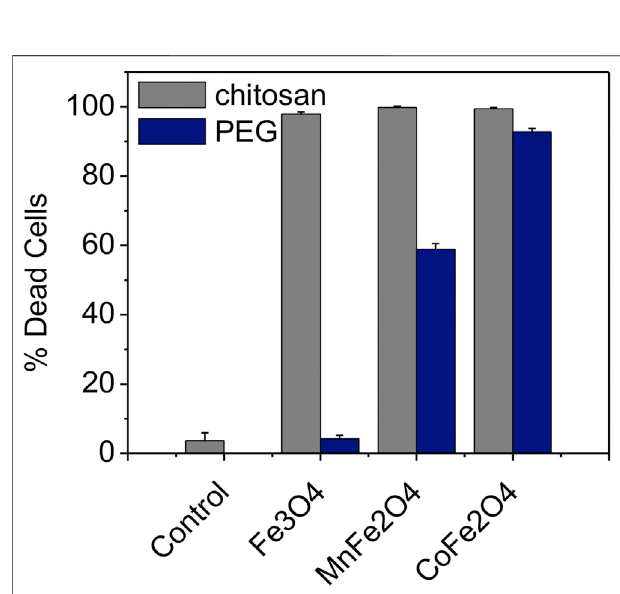
FIGURE 10 | Necrosis of 9 L tumor cells induced by 30 min of rf induction heating for chitosan (gray bars) and PEG-coated (blue bars) Fe 3 O 4 , MnFe 2 O 4 , and CoFe 2 O 4 nanoparticles. The concentration for all samples was 2 mg/ml in PBS (H (cid:2) 76 mT and f (cid:2) 400 kHz). Control cells were exposed to rf heating without particles (just